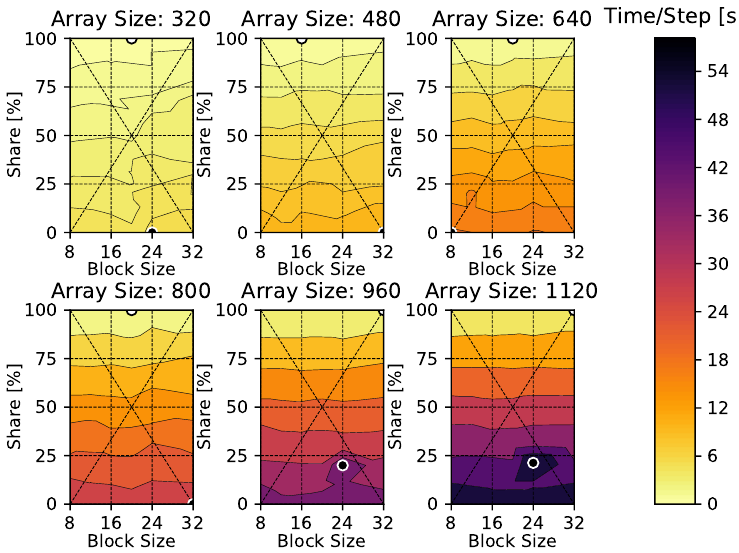
Figure A5. Euler equations time per timestep performance using Swept to solve the Euler equations with Intel E5-2698v4 CPUs and Tesla V100-DGXS-32GB GPUs.